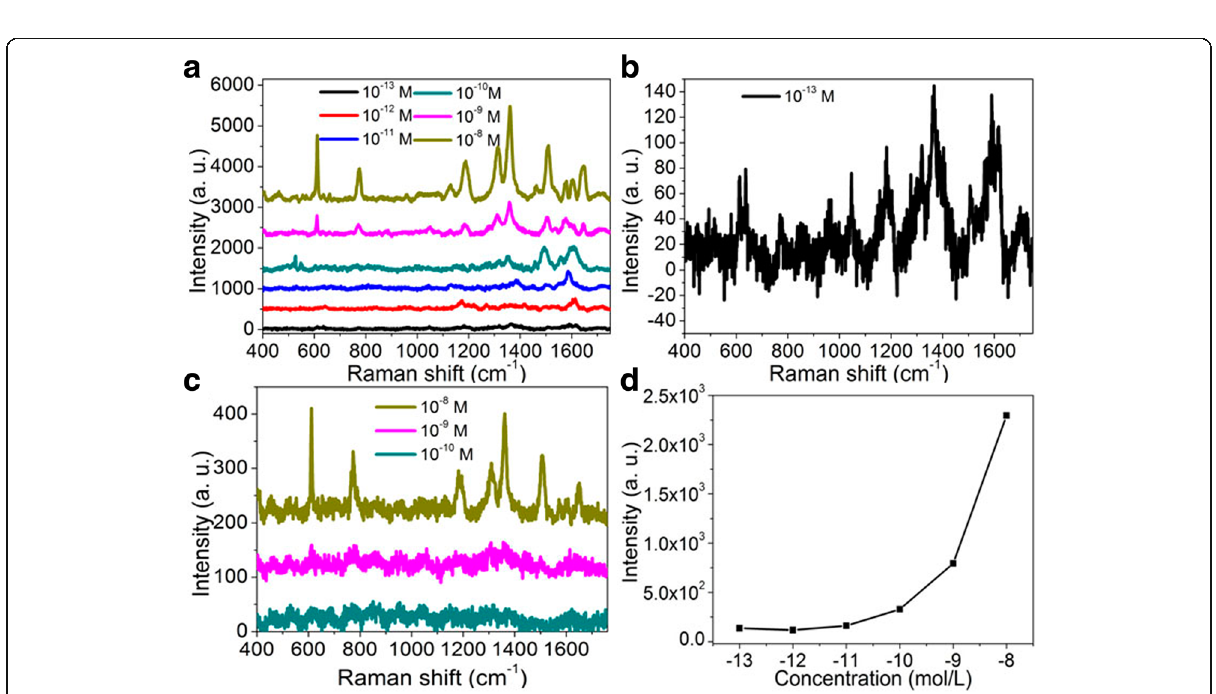
Fig. 12 a Raman spectra of R6G molecules with the concentration changing from 10 − 8 M to 10 − 13 M in the dual-layer porous Au films. b Magnified Raman spectra of R6G molecules with the concentration of 10 − 13 M in the dual-layer porous Au films. c Raman spectra of R6G molecules with the concentration changing from 10 − 8 M to 10 − 10 M in the single-layer porous Au film. d The relationships of peak intensities at 1368 cm − 1 and the logarithmic concentrations of R6G. The sputtering time of each layer of porous Au films is 47 s. Laser power: 0.24